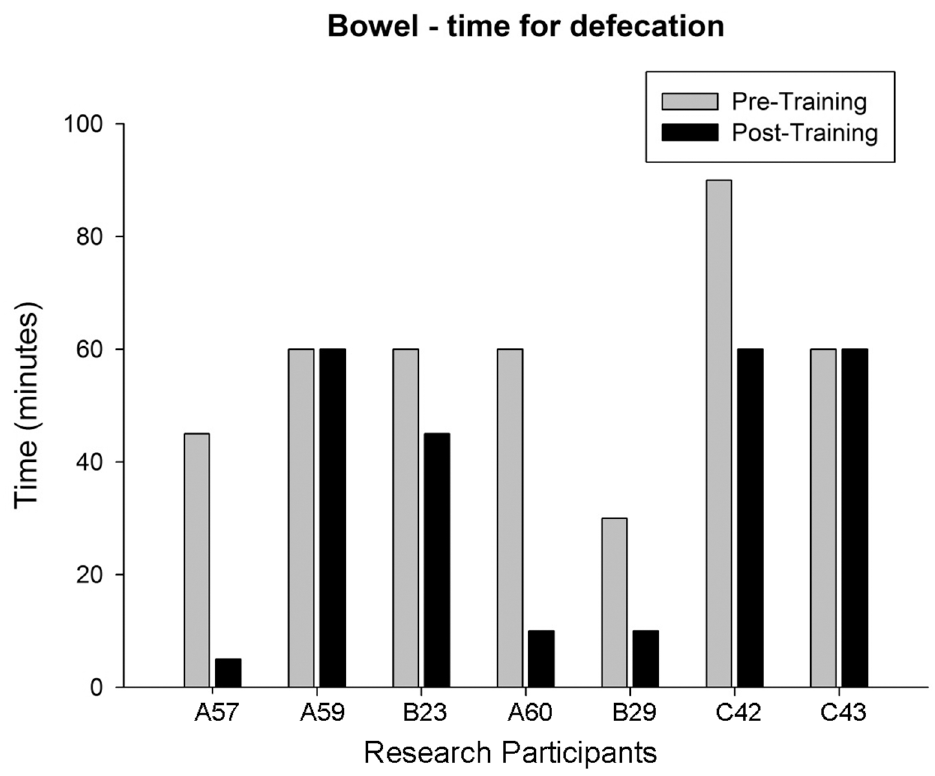
Fig 9. Participant estimated time for defecation. Average time for defecation over “last four weeks” for seven of eight research participants (bowel data set used beginning with participant A57). Pre-/post-training group means were 57.9 ± 18.2 and 35.7 ± 26.2, respectively. A binomial proportion test indicates that a significant majority of the research participants demonstrated an improvement in bowel function (vs. random occurrence, p < .05).